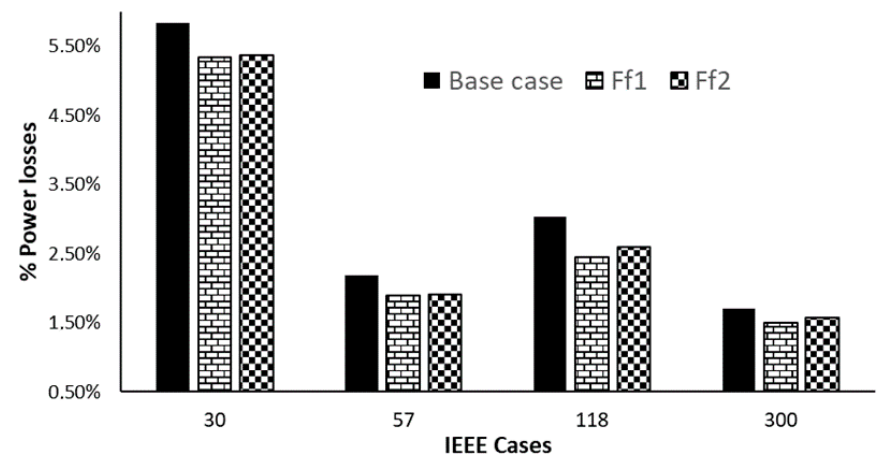
Figure 10. Percentage of loss reduction for different test cases.